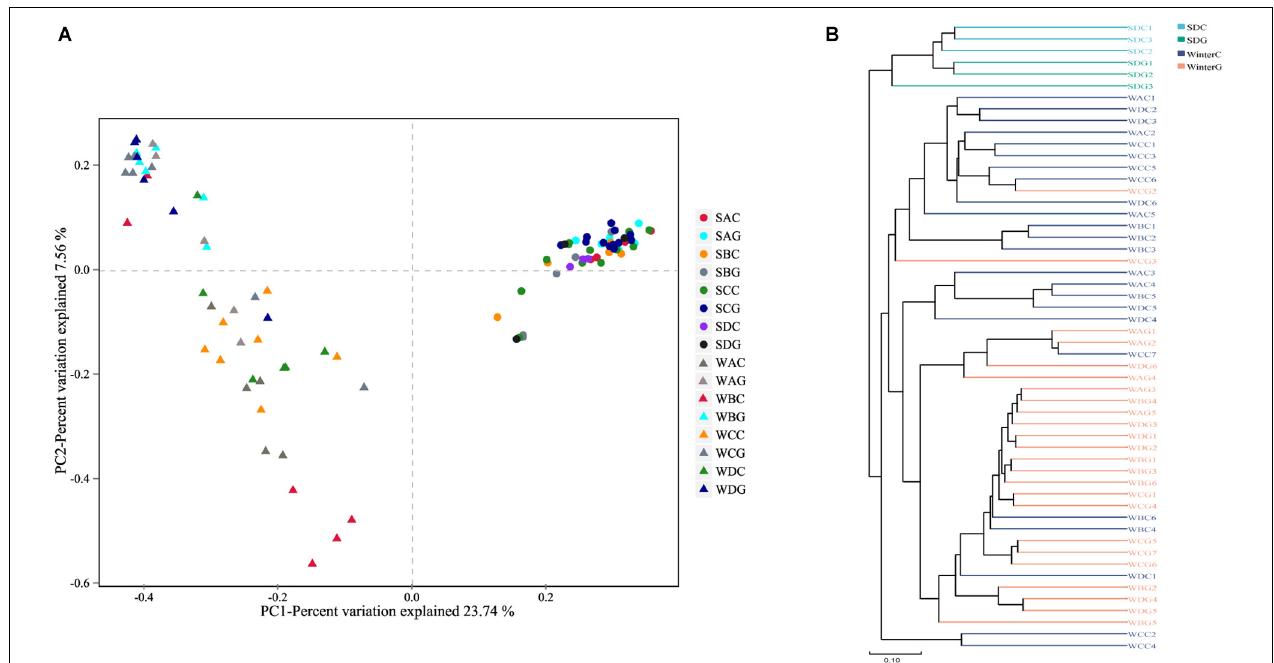
FIGURE 2 | Boxplots depict differences of beta diversity between intestinal and hepatopancreas samples. (A) Summer shrimps; (B) winter shrimps. Beta diversity of intestinal and hepatopancreas mycobiota. (A) Principal coordinate analysis (PcoA) was based on Bray–Curtis distance. (B) A clustering dendrogram was constructed using an unweighted pair-group method with arithmetic mean (UPGMA).